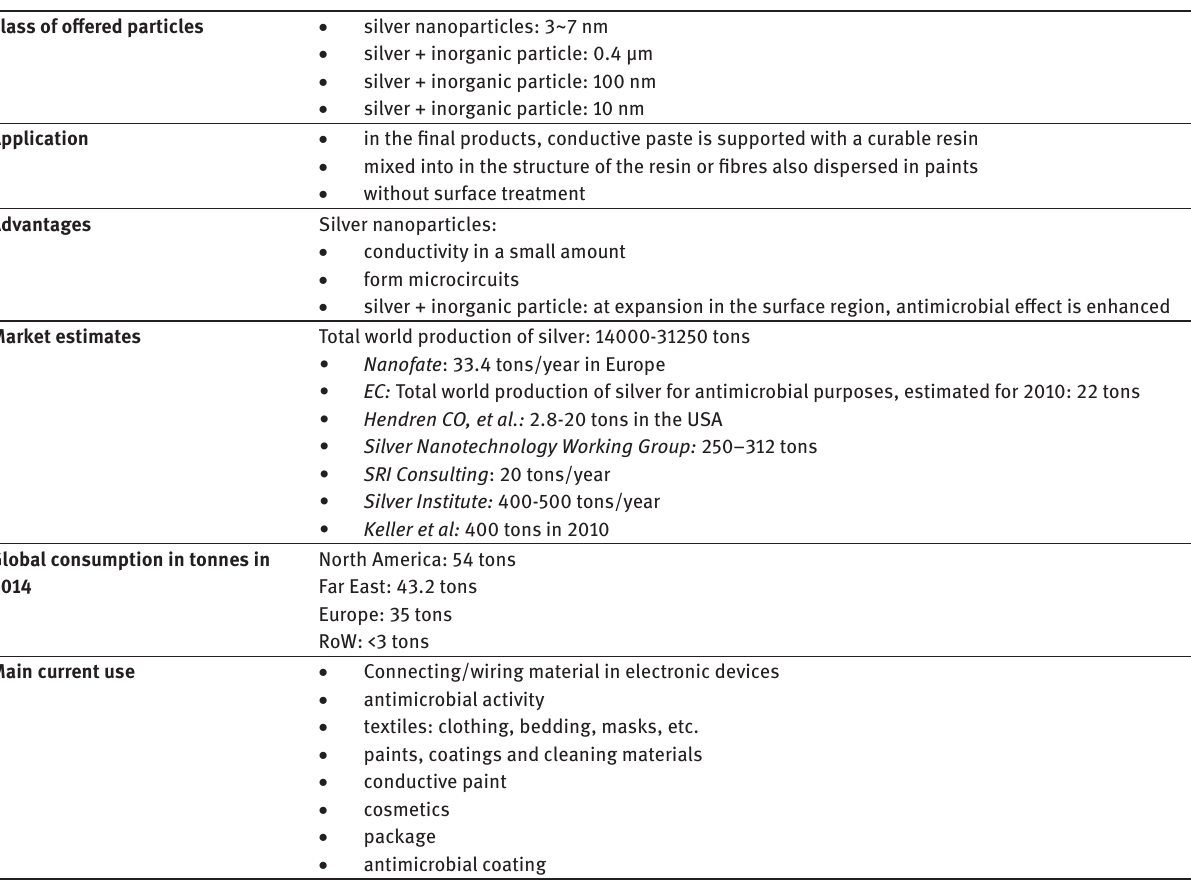
Table 4: Summary of silver nanoparticles global market [3].